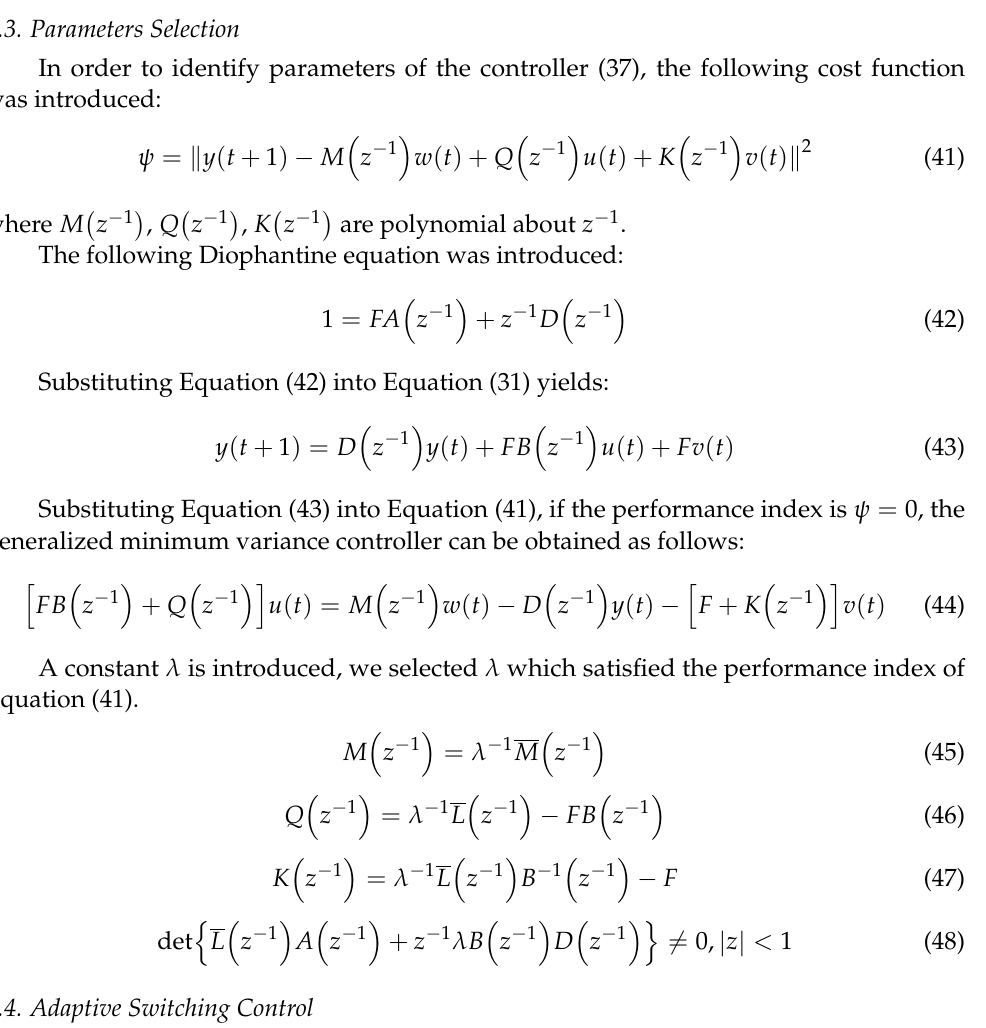
Figure 5. Nonlinear control strategy.